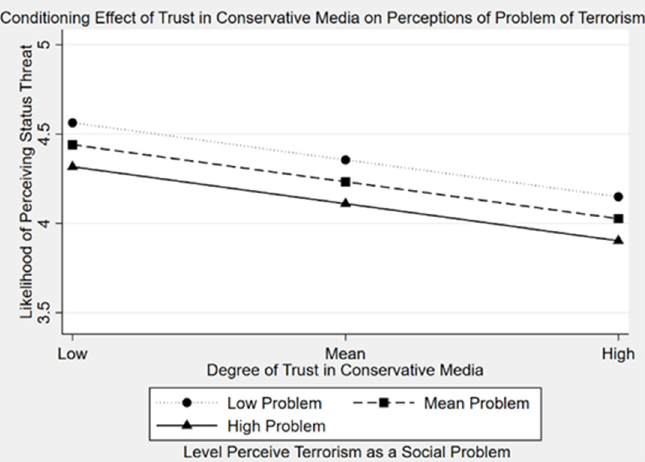
Figure 3. Conditioning Effect of Conservative Media: Terrorism and Status Threat.